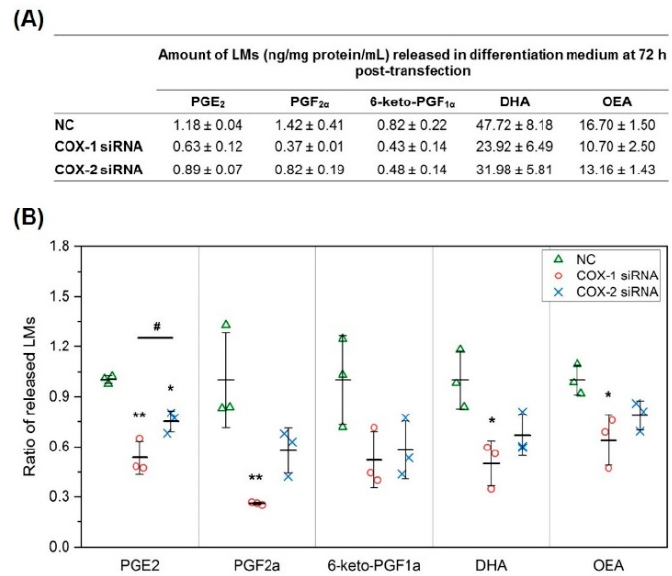
Figure 2. COX-1 and -2 knockdown reduces the levels of key lipid mediators released by primary muscle cells. ( A ) Absolute quantification of lipid mediators (LMs) released in differentiation medium (DM) from primary mouse myocytes/myotubes during differentiation; ( B ) ratio of LMs released in DM at 72 h post-transfection comparing COX-1 siRNA or COX-2 siRNA treatment with NC transfection. n = 3, * p < 0.05 and ** p < 0.01 compared with NC; # p < 0.05 compared with COX-1 siRNA.